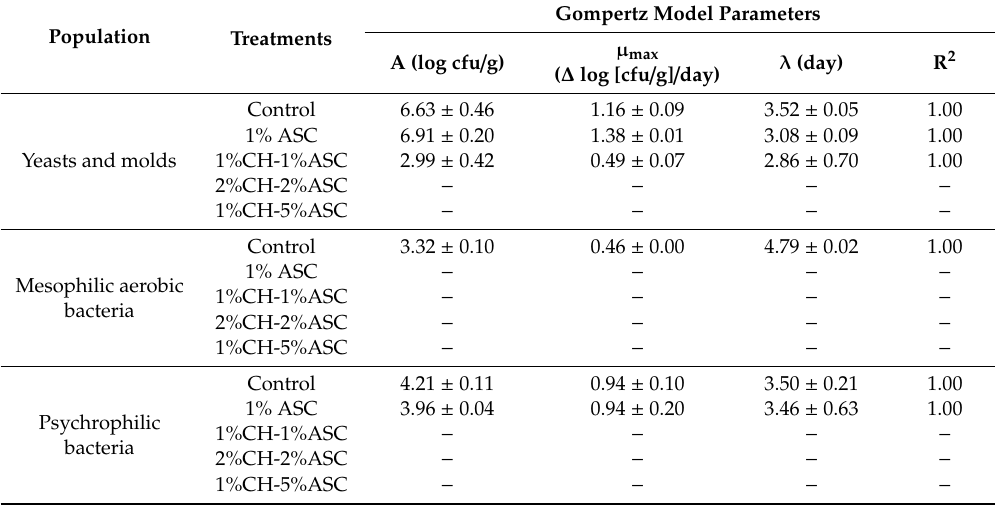
Table 5. Gompertz model parameters for the growth of yeasts and molds, psychrophilic and mesophilic bacteria in fresh-cut apples during storage at 5 ◦ C *.